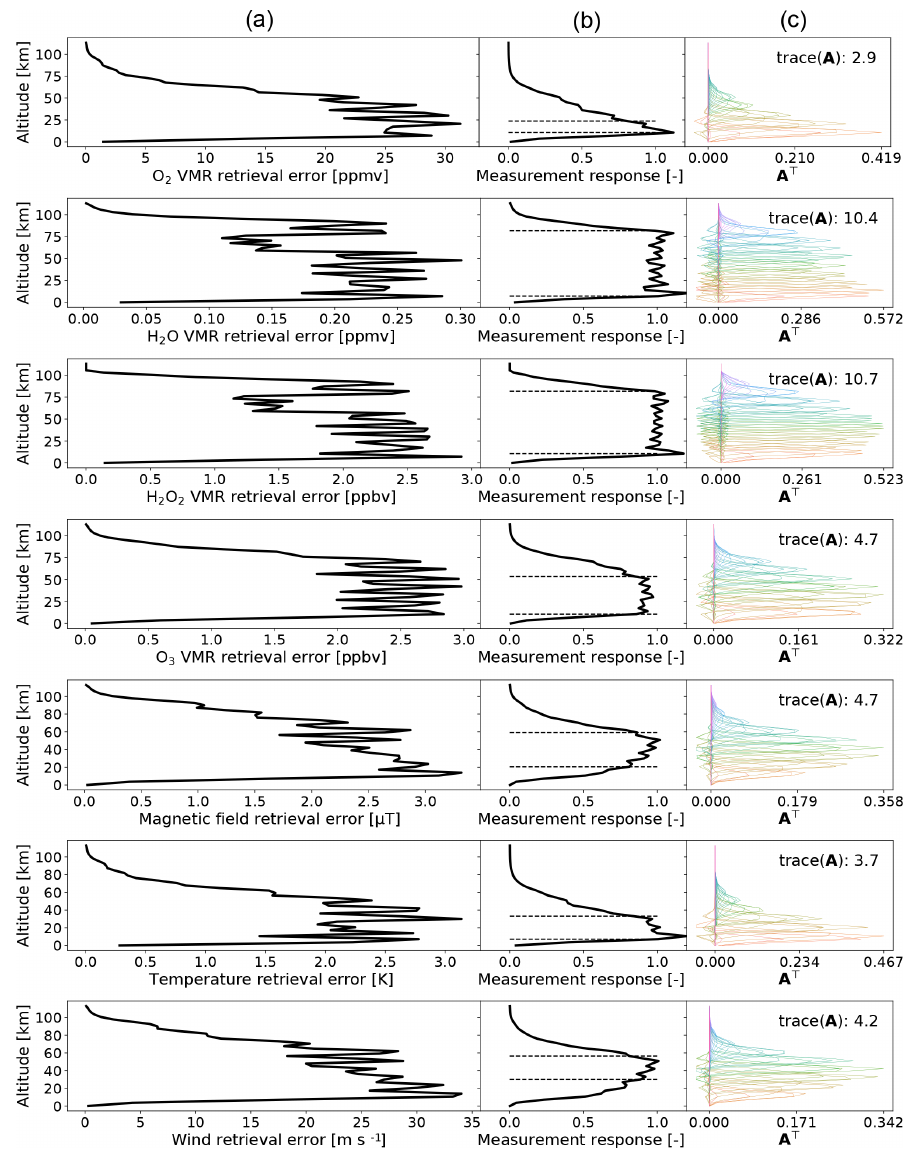
Figure 6. Same as Fig. 5 but with gaseous water, hydrogen peroxide, and ozone lowered by a factor of 100 to the atmosphere of Fig. 2 and a magnetic field strength of 10nT. Also, molecular oxygen is left out of this figure because it is not affected by the